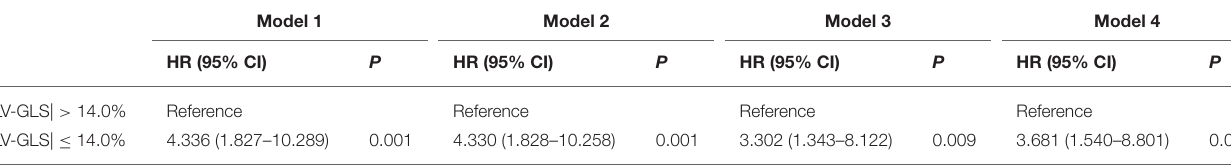
TABLE 5 | Cox proportional hazards model of clinical outcomes (nested analysis).